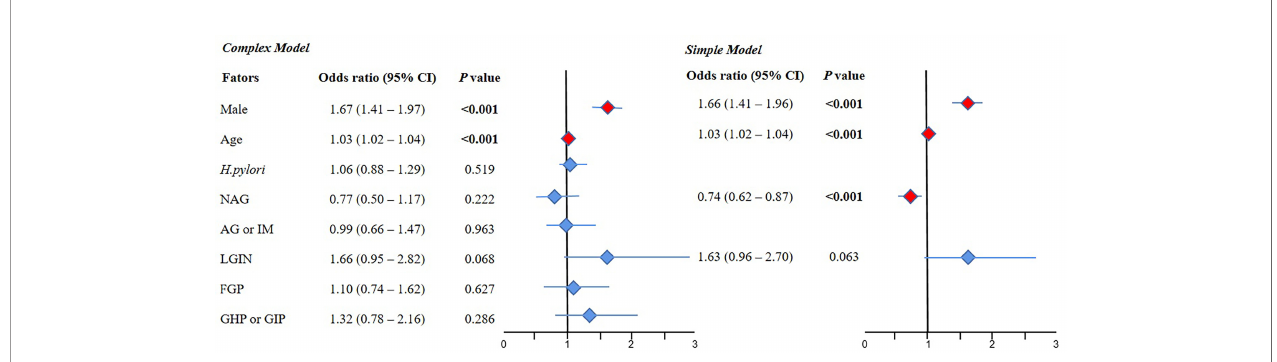
FIGURE 2 | The results of multivariate logistic regression for the NAP group compared with the normal group. 95% CI, 95% con fi dence interval; NAG, non-atrophic gastritis; AG or IM, atrophy/intestinal metaplasia; FGP, gastric fundus gland polyp; GHP or GIP, hyperplastic/in fl ammatory gastric polyp; LGIN, low-grade intraepithelial neoplasia. Complex model: All variables were included, and then P values were calculated separately. Simple model: Based on the complex model and the stepwise regression method, an optimal simple model is obtained, which is automatically screened according to the Akaike information criterion (AIC) minimization